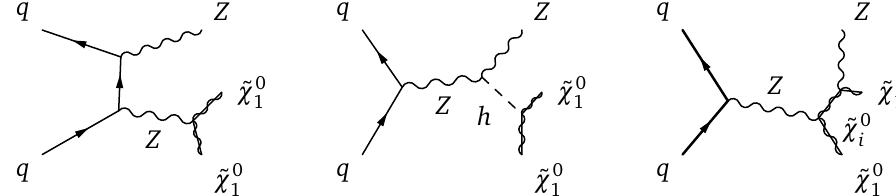
Figure 5: Feynman diagrams contributing to mono- Z production in the MSSM, in- cluding initial-state Z -radiation with a Z -portal, Zh production with a SM-like Higgs portal, and heavy neutralino